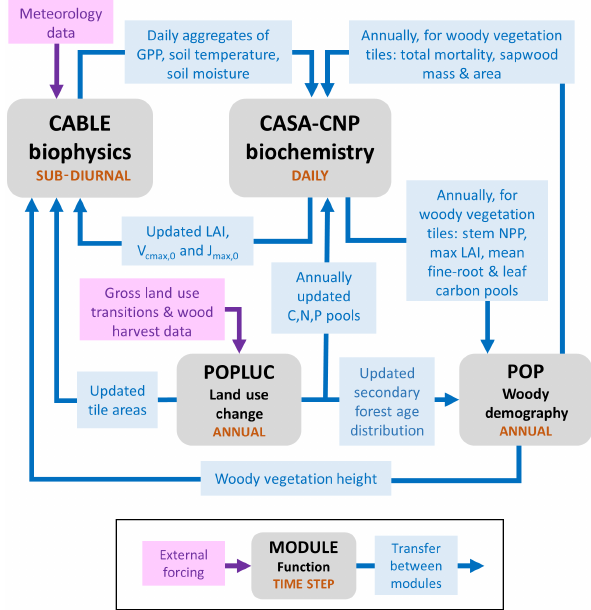
Figure 1. Major sub-models of CABLE (revision 4601) showing forcing data, characteristic time steps and information flows be- tween modules, which include fluxes, store updates, and changes to vegetation characteristics and their spatial extent (tile areas) within grid cells. Data from faster modules are aggregated before pass- ing to slower modules. Faster modules are updated with data from slower modules at the rate of the slower time